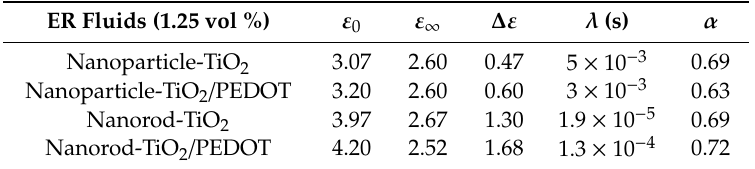
Table 1. Fitting parameters of Equation (4) for ER fluids in Figure 8 (Eroal et al. [88], © The Royal Society of Chemistry,